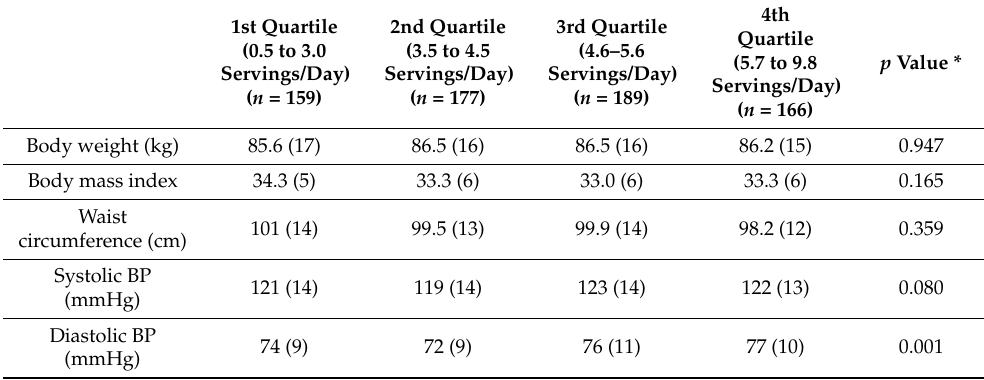
Table 2. Baseline anthropometrics, BP, lipid contents, and inflammatory and oxidative damage markers according to fruit and vegetable consumption quartiles, mean